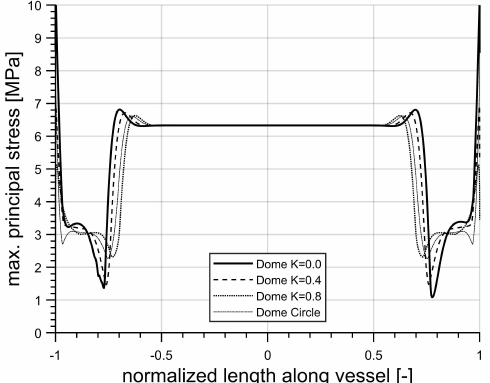
Figure 8. Maximum principle stress in the liner without nonlinear geometry.